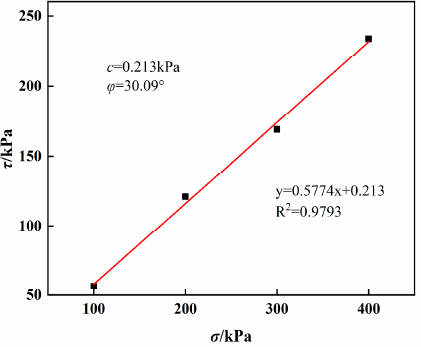
Figure 12. Relation curve between shear strength and vertical pressure.